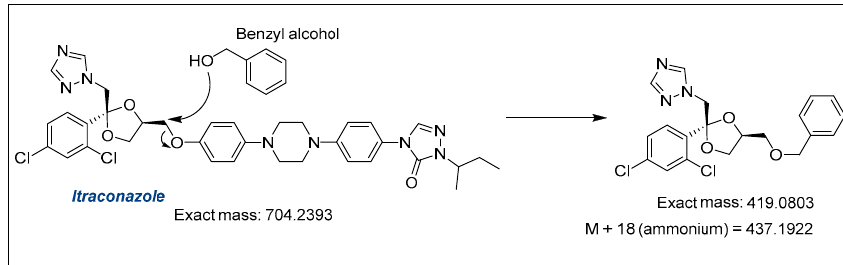
Figure 11. Scheme showing the reaction between itraconazole and benzyl alcohol.